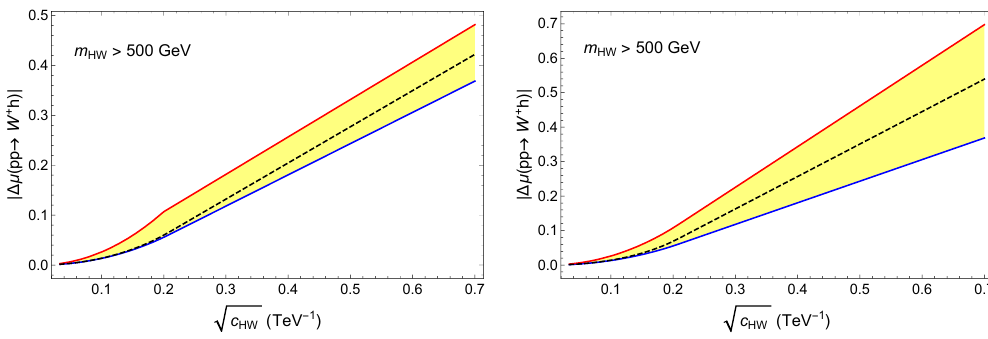
Figure 3 . Relative deviation in the high-mass cross section (cid:27) ( pp ! h W + ; m HW > 500 GeV) at p the LHC ( s = 13 TeV) from its SM value including dimension-6 and dimension-8 e(cid:11)ects. In the left panel, all dimension-8 coe(cid:14)cients are taken to be positive, while in the right panel the signs of the coe(cid:14)cients enhance the impact of dimension-8 operators on this cross section. The blue, red, and dashed black lines correspond to the same scenarios as in (cid:12)gure